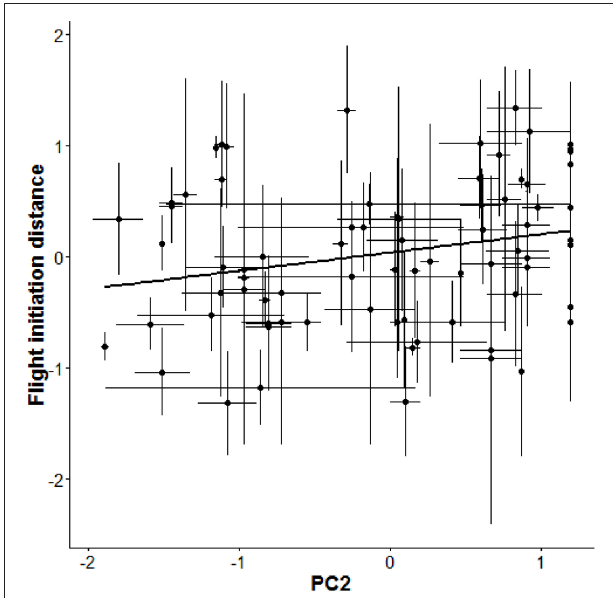
FIGURE 2 | Among-individual variation in flight initiation distance (FID) as a function of the compound environmental gradient PC2 that combines number of pedestrians and cars (more positive loadings represent more pedestrians and lower loadings more cars). As individuals do not plastically respond to changes in PC2 ( Table 1 ), the relationship implies a non-random distribution of individual-level behavioral type along this urban gradient. The thick black line presents the regression line between FID and PC2 based on the fitted GLMM ( Table 1 ). Shown are average scores ±